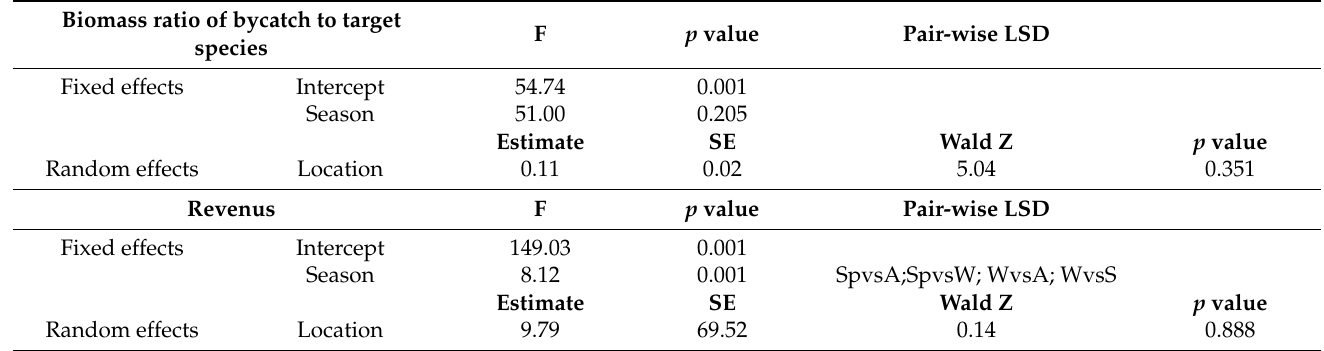
Table A4. Linear Mixed Model Effects results regarding biomass ratio of bycatch to target species and revenues of the catch with season (fixed factor) and location (random factor) as predictors.